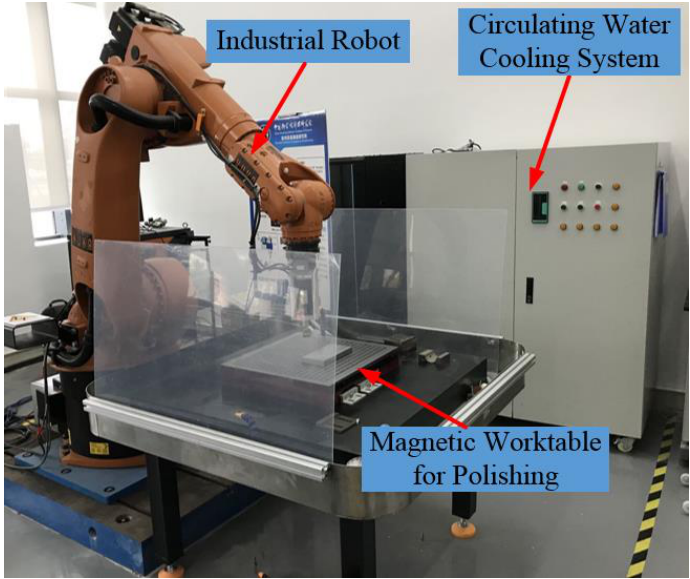
Figure 1. The robotic polishing platform with force control.